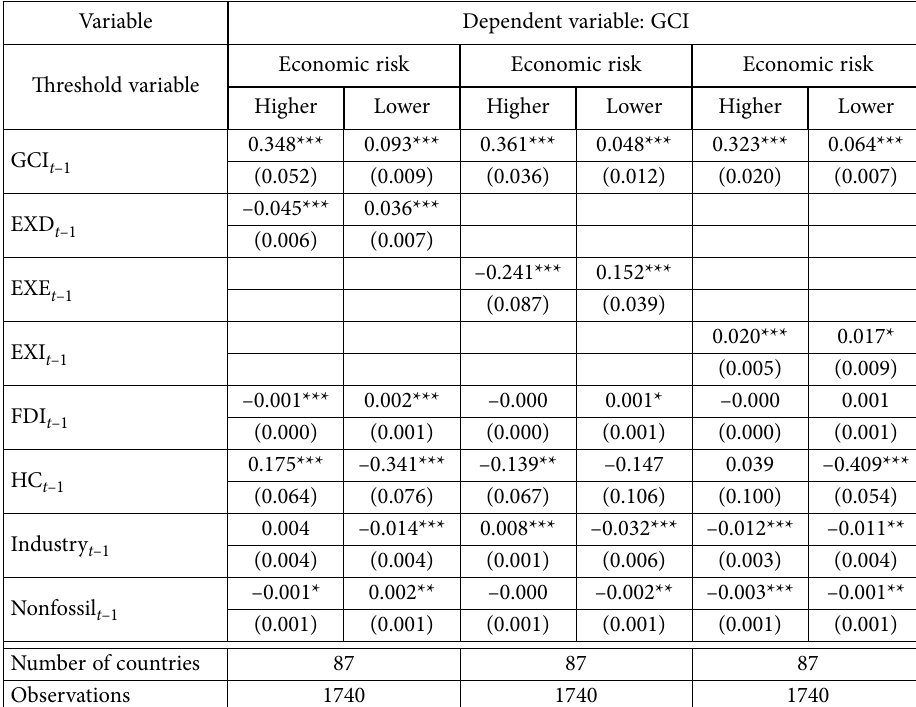
Table 9. DPT estimations for GCI (threshold =